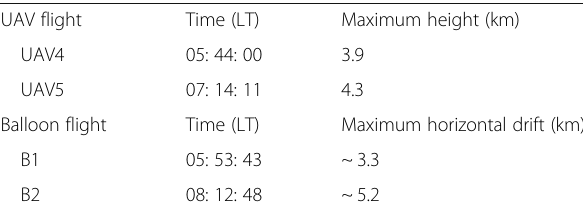
Table 3 Brief description of the selected UAV flights (07 June 2015) and Vaisala radiosondes UAV